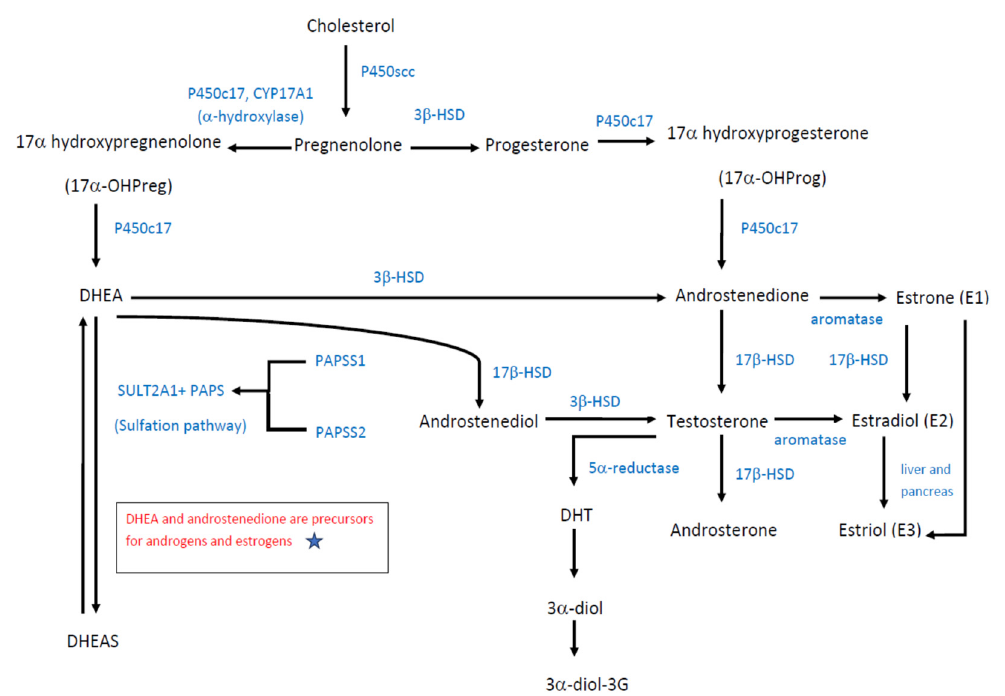
Figure 2. Biosynthesis of DHEA. In addition, DHEA is a crucial intermediate in maintaining steroidogenesis. Skele- tal muscle is a sex steroid-sensitive tissue and is capable of locally synthesizing 5 α - dihydrotestosterone (DHT) from either testosterone or DHEA. Testosterone is directly metabolized to DHT through 5 α -reduction, while DHEA is metabolized to DHT with the assistance of 3 β -HSD, 17 β -HSD, and 5 α -reductase enzymes [15,16]. As a potent an- drogen, DHT can be converted to androstane-3 α ,17 β -diol (3 α -diol), and subsequent 3 α - diol-3-glucuronide (3 α -diol-3G), thus activating the glucose metabolism-related signaling pathway [15] (Figure 2). Adrenal androgens, compounds of 19-carbon steroids, are mainly synthesized in the zona reticularis of the adrenal cortex. Adrenal androgens include DHEA, DHEA-S, an- drostenedione, and androstenediol. Androstenedione is an androgenic steroid produced by the testes, adrenal cortex, and ovaries. While androstenedione is converted to testos- terone and other androgens, it is also a precursor of estrone (E1). Androstenediol is a